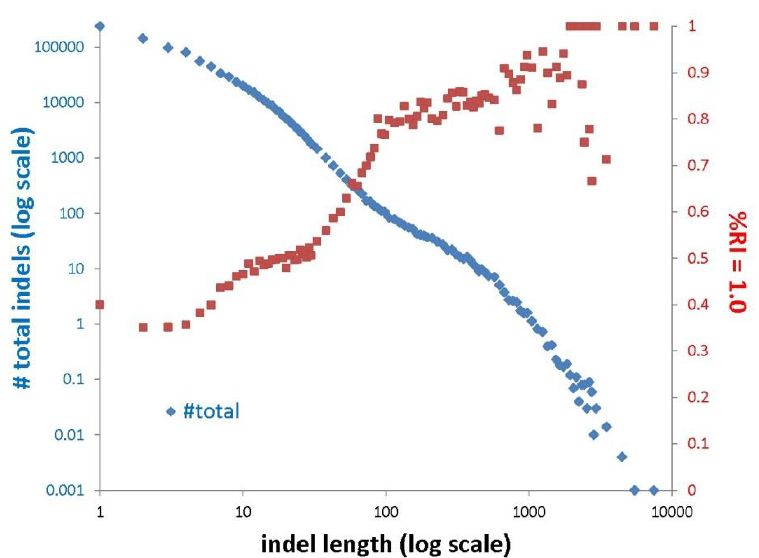
Figure 3. Numbers of indels and estimates of their homoplasy are related to indel size. Indel frequency (blue; log scale) and the percentage of indels that are parsimony consistent (red) as a function of indel length (log scale). We defined indels as parsimony consistent if they have RI = 1.0 on a specific tree. We used the “Total Evidence Indel Tree” (TEIT; Figure S12 in Jarvis et al. [15]) as that estimate of the avian species tree because it reflects indel data (it is based on concatenated exon, intron, and UCE indels). The curve for the percentage of parsimony consistent indels resembles a step function. This likely reflects the fact that the accumulation of indels over evolutionary time involves multiple mechanisms. The case where 100% of the characters have RI = 1.0 (i.e., the situation for the largest indels above) is consistent with the absence of true homoplasy as well as complete lineage sorting.